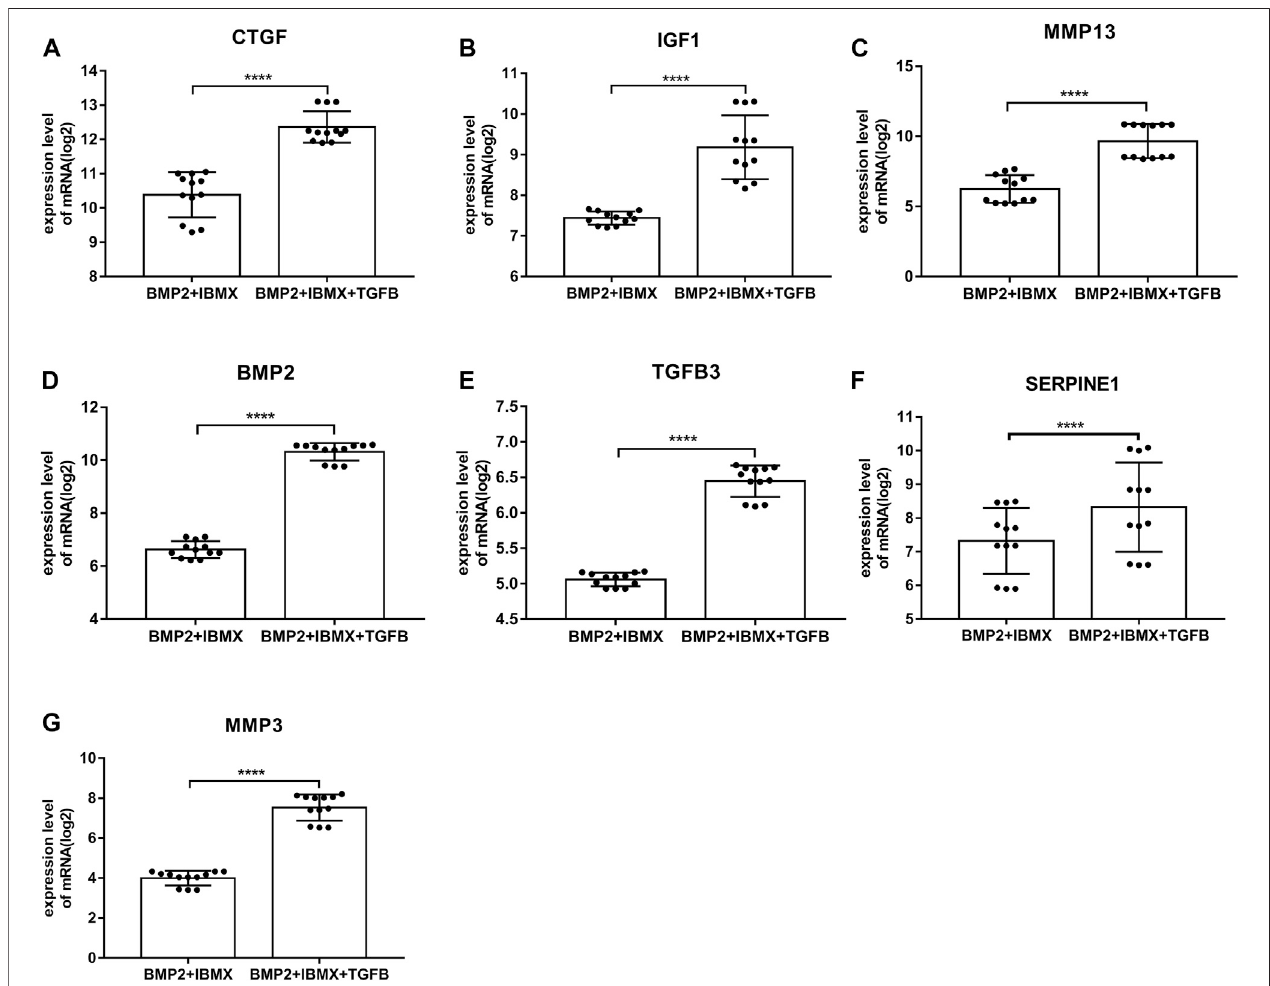
FIGURE 5 | mRNA expression levels of the top seven upregulated hub genes involved in osteogenic differentiation, derived from analysis of 24 samples from four time-points (1, 2, 3, and 7 days; presented on a log2 scale). The data shown are means ± SD. * p < 0.05, ** p < 0.01, *** p < 0.001, **** p < 0.0001.